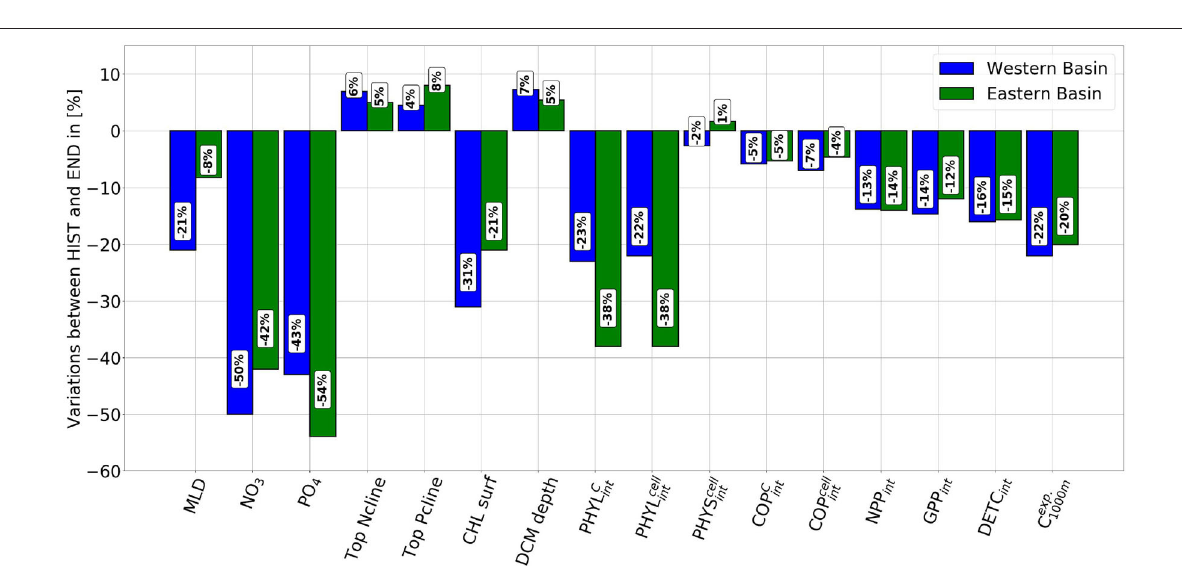
at the END period, a reduction of 13.8% (10%) (see Figure 5 ). In the Eastern Basin, NPP int declines from 20.3 to 17.3 gC · m − 2 · a − 1 between the HIST and the END periods (i.e., a reduction of